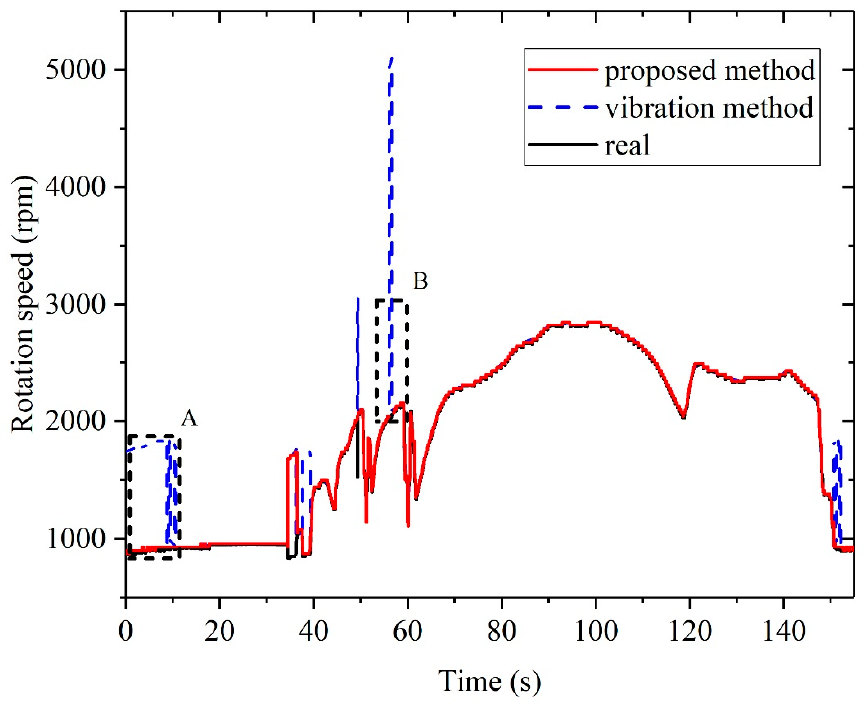
Figure 7. Test results of rotation speed measurement.